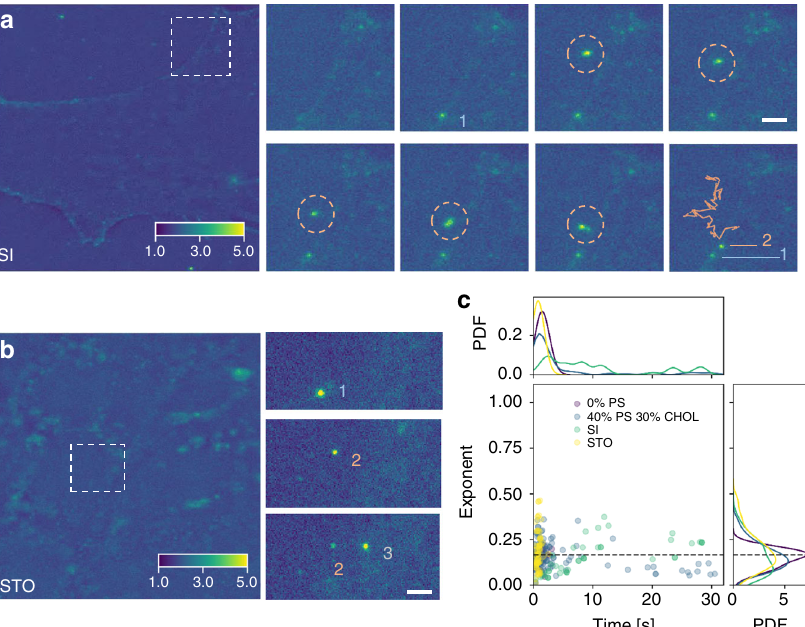
Fig. 8 Individual cubosome uptake by cells. a TIRF image and magni fi ed snapshots for cubosome uptake with small intestine (SI) cells. The times for the snapshots are 0 s, 0.03 s, 0.39 s, 0.45 s, 1.5 s, 1.8 s, 1.86 s, 1.9 s, respectively. The motion and trace of the second cubosome labelled two is highlighted by the pink circles and line, respectively. Scale bar = 1.5 µ m. b TIRF snapshots for cubosome uptake with STO fi broblast cells. Scale bar = 1.5 µ m. c Distribution of fusion times and fi tted exponents for 1% DOTAP cubosomes with DOPC bilayer (purple), 40% DOPS 30% CHOL bilayer (blue), SI (green) and STO (yellow). The plot includes 126 and 117 unique cubosome interactions for SI and STO,